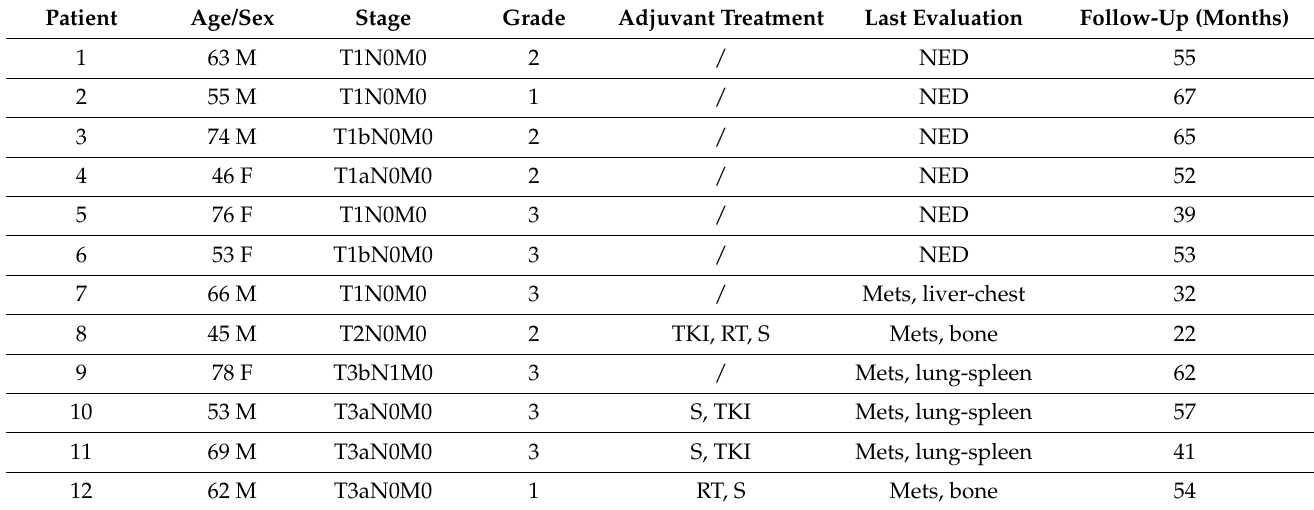
Table 2. Patients’ characteristics. TKI: Tyrosine-kinase inhibitor; RT: radioteraphy; S: Surgery; Mets: metastatic disease; NED: no evidence of